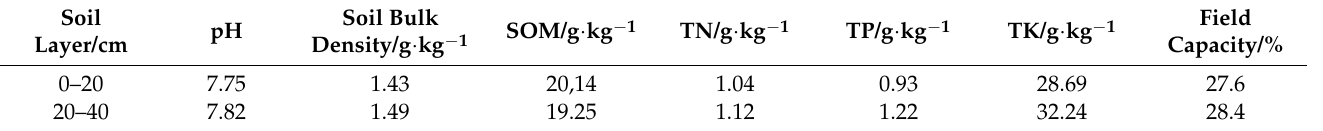
Table 1. The basic physical and chemical properties in the 0 – 40 cm soil layer.